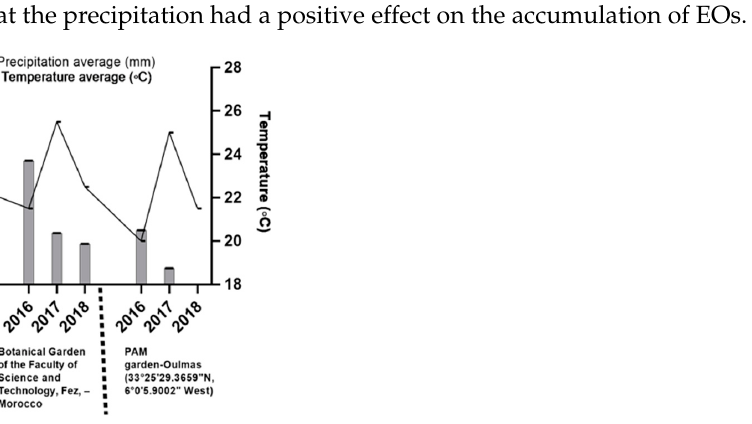
Figure 2. Variation of climatic conditions in the collection regions of Ro , La , and Ca between June 2016 and June 2018. Data are collected from: https://www.meteoblue.com/fr/meteo/historyclimate/weatherarchive/figuig_maroc_6546275 (Accessed date: 15 June 2021). The binary combination Ro : La sample yielded 2.26 ± 0.04% mL/100 g of plants ( p -value < 0.001), a yield higher than the tertiary combination samples obtained by simulta- neous hydrodistillation–steam distillation, where similar yields values (1.50–1.65% mL/100 g of plants) were observed (Table